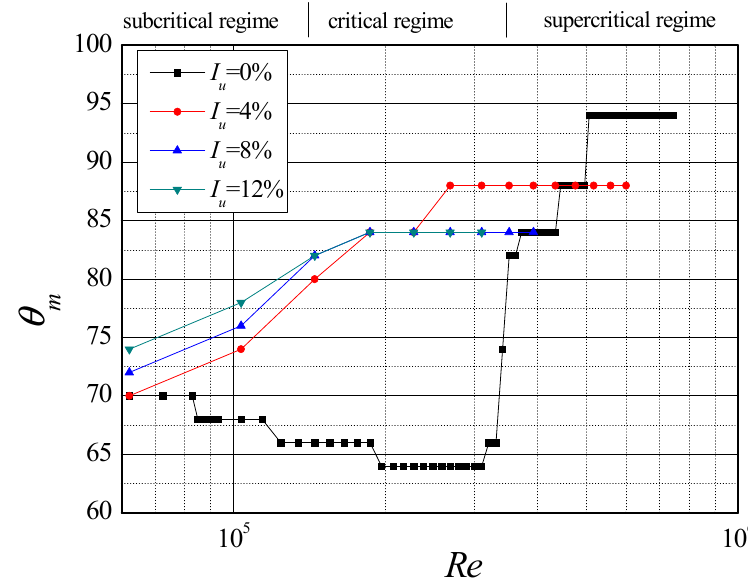
Appl. Sci. 2019 , 9 , x FOR PEER REVIEW Figure 12 . The angular position of minimum wind pressure coefficient θ m in the turbulent flow. Figure 12. The angular position of minimum wind pressure coe ffi cient θ